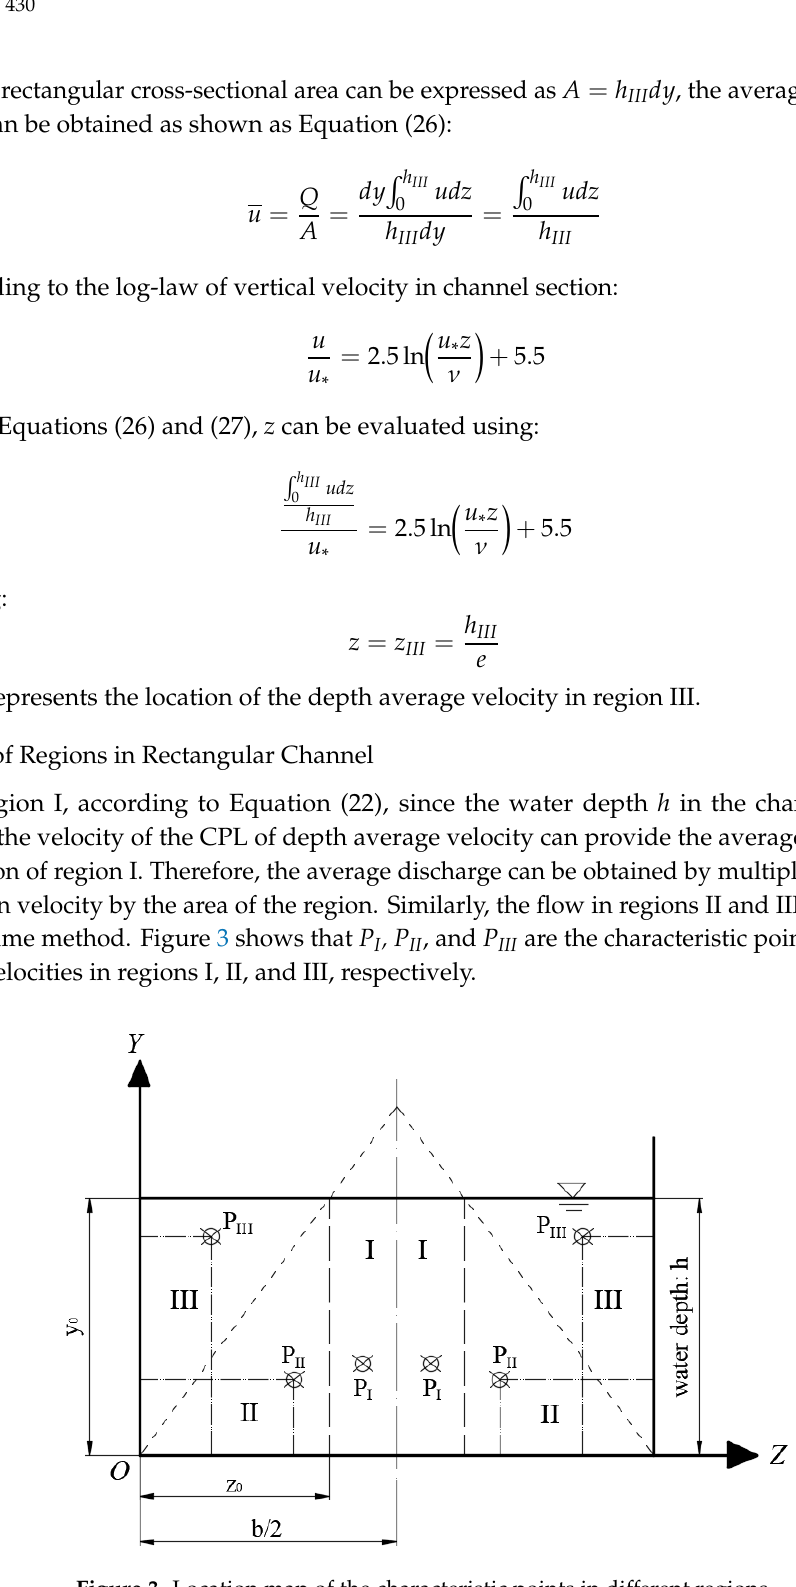
Figure 3. Location map of the characteristic points in different regions.